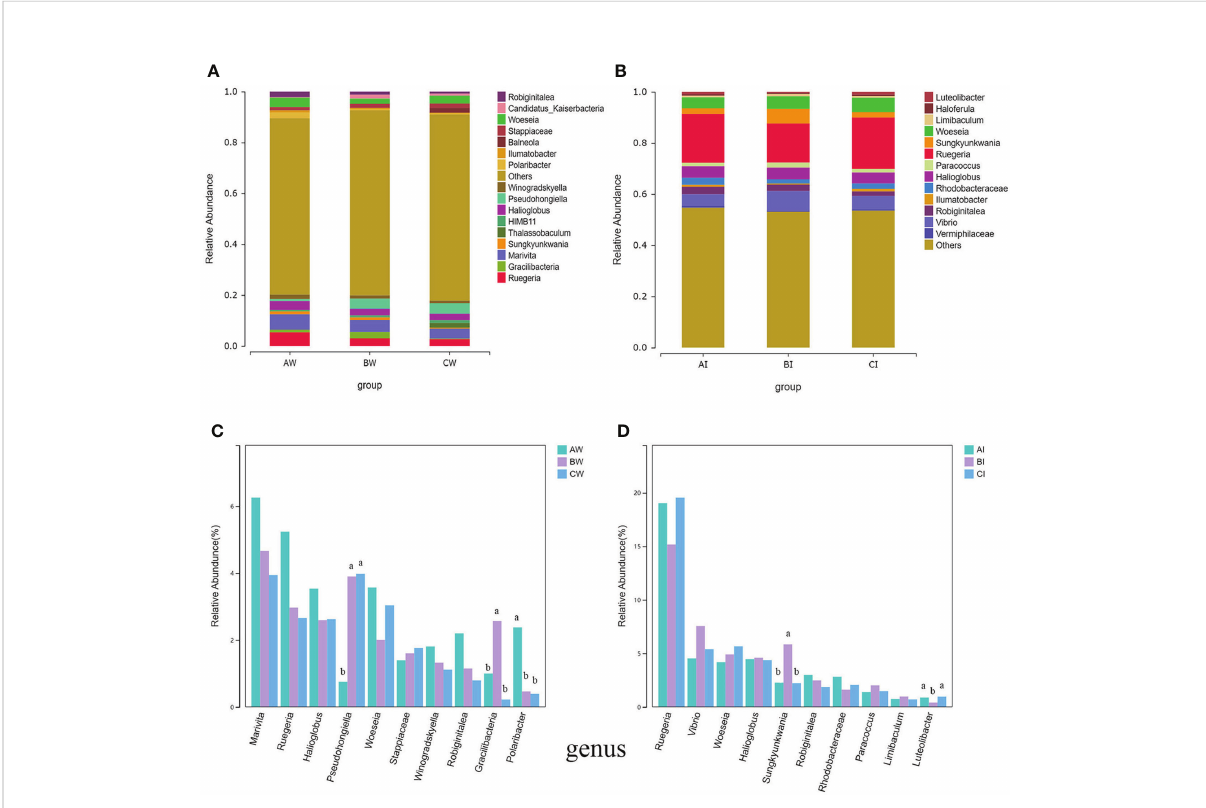
FIGURE 5 Effect of sodium humate (BW, BI) and sodium humate with probiotics (CW, CI) on bacterial community composition and the top 10 dominant bacteria at the genus level in the culture water (A, C) and intestine (B, D) of L. vannamei . Bars labelled with different letters denote signi fi cant differences ( p < 0.05) between the experimental